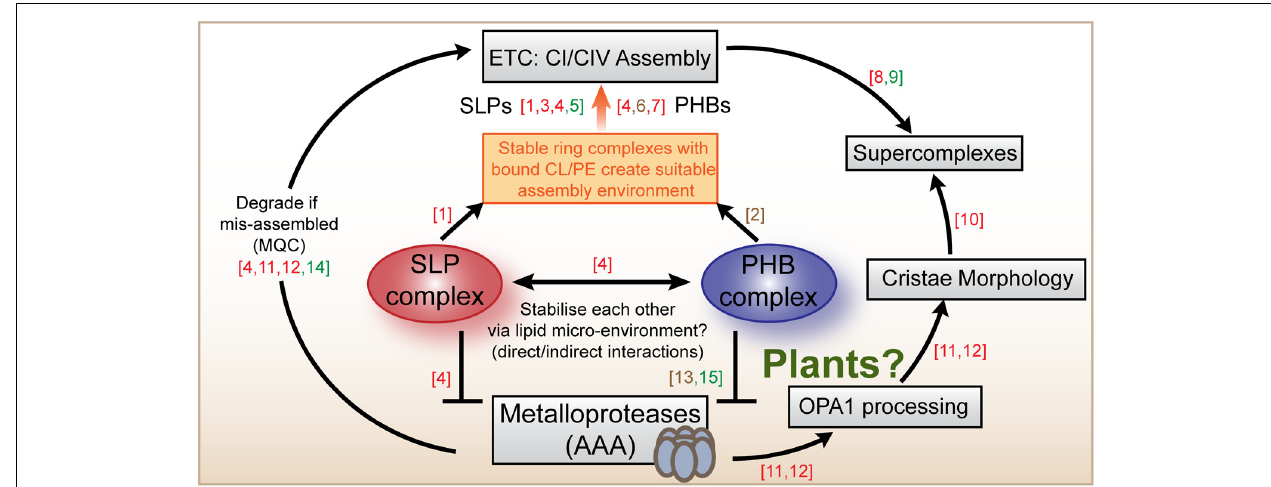
FIGURE 2 | Summary scheme of SLP and PHB functions across species. The SLP and the PHB complexes are localized to the mitochondrial inner membrane where they probably bind to cardiolipin and/or phosphatidylethanolamine and participate in the assembly of complexes I and complex IV. In animal cells, SLPs and PHBs have been located to the same complexes (250 kDa) and have been demonstrated to interact. Both are implied to inhibit the activities of chaperone-like proteases of the AAA type which are also embedded in the inner membrane. PHBs from plants and from yeast form a complex with mAAA proteases. AAA proteases are known to participate in mitochondrial quality control (MQC) mechanisms that ensure appropriate electron transport chain (ETC) assembly and